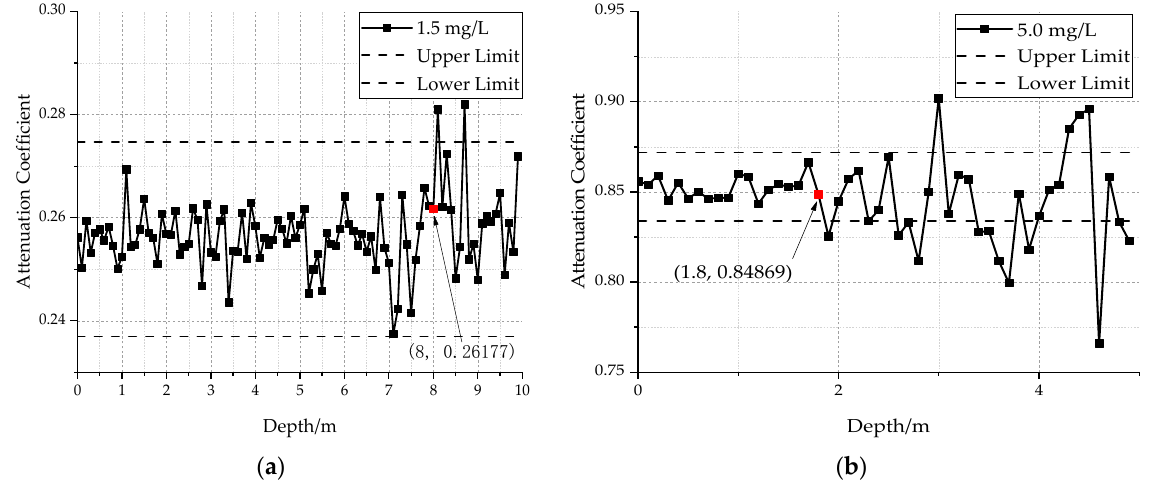
Figure 2. Variation curve of extinction coefficients for 532 nm laser with the transmission depths in seawater containing suspended matter concentrations of ( a ) 1.5 mg/L and ( b ) 5.0 mg/L.